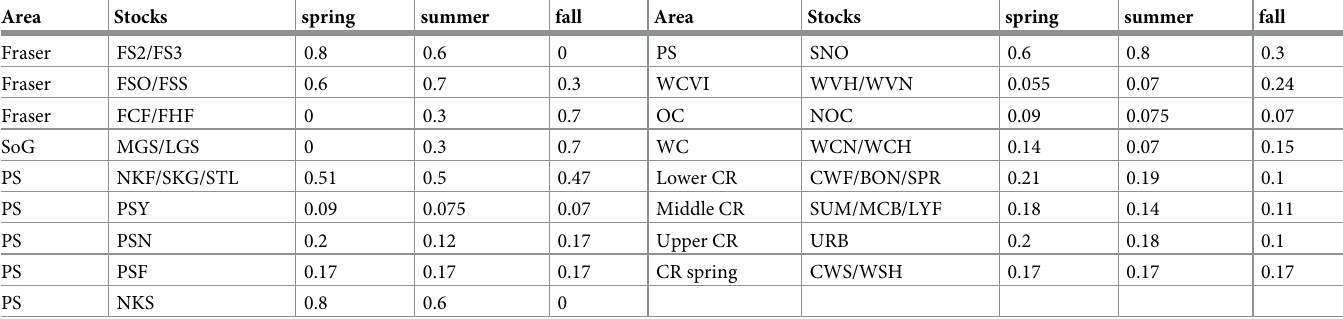
Table 3. Estimated seasonal proportions P of the fall run and migrating spring and summer mature Chinook salmon present in the Salish Sea and along the West s Coast of Vancouver Island in the spring, summer, and fall. Area